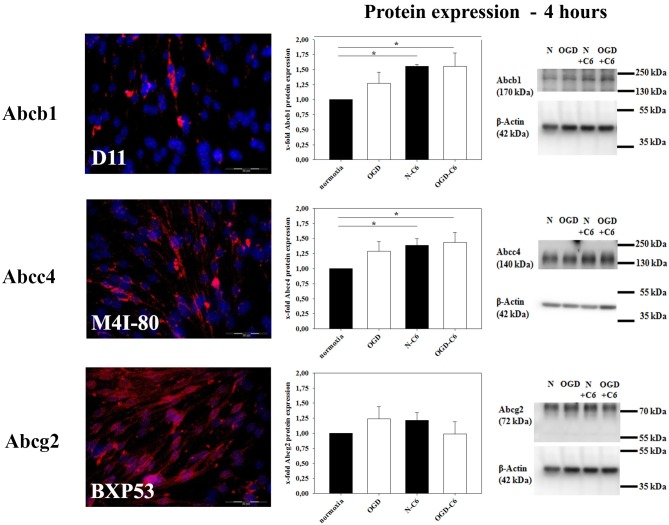
Influence of 4 h oxygen/glucose deprivation (OGD) treatment and presence of astrocyte soluble factors on protein expression of Abc-transporters Abcb1, Abcc4, and Abcg2 of cerebEND cells. Immunofluorescence images of cerebEND cells under normoxic conditions show the distribution of Abcb1, Abcc4, and Abcg2. In the middle, results of densitometric analysis derived from western blots of total protein cell lysates are presented, on the right side according representative western blot images are depicted. N, cerebEND normoxic control; OGD, cerebENDs treated under OGD conditions for 4 h; N−C6 or N+C6, cerebENDs treated for 4 h with C6 conditioned medium derived from C6 cells which were treated under normoxic control conditions for 4 h, OGD−C6 or OGD+C6, cerebENDs treated for 4 h OGD with C6 conditioned medium derived from C6 cells which were treated under OGD conditions for 4 h. Statistical significance was labeled with *(p < 0.05, two-sided student's t-test with same variances). Data are presented as means ± s.e.m. (n = 4-6).